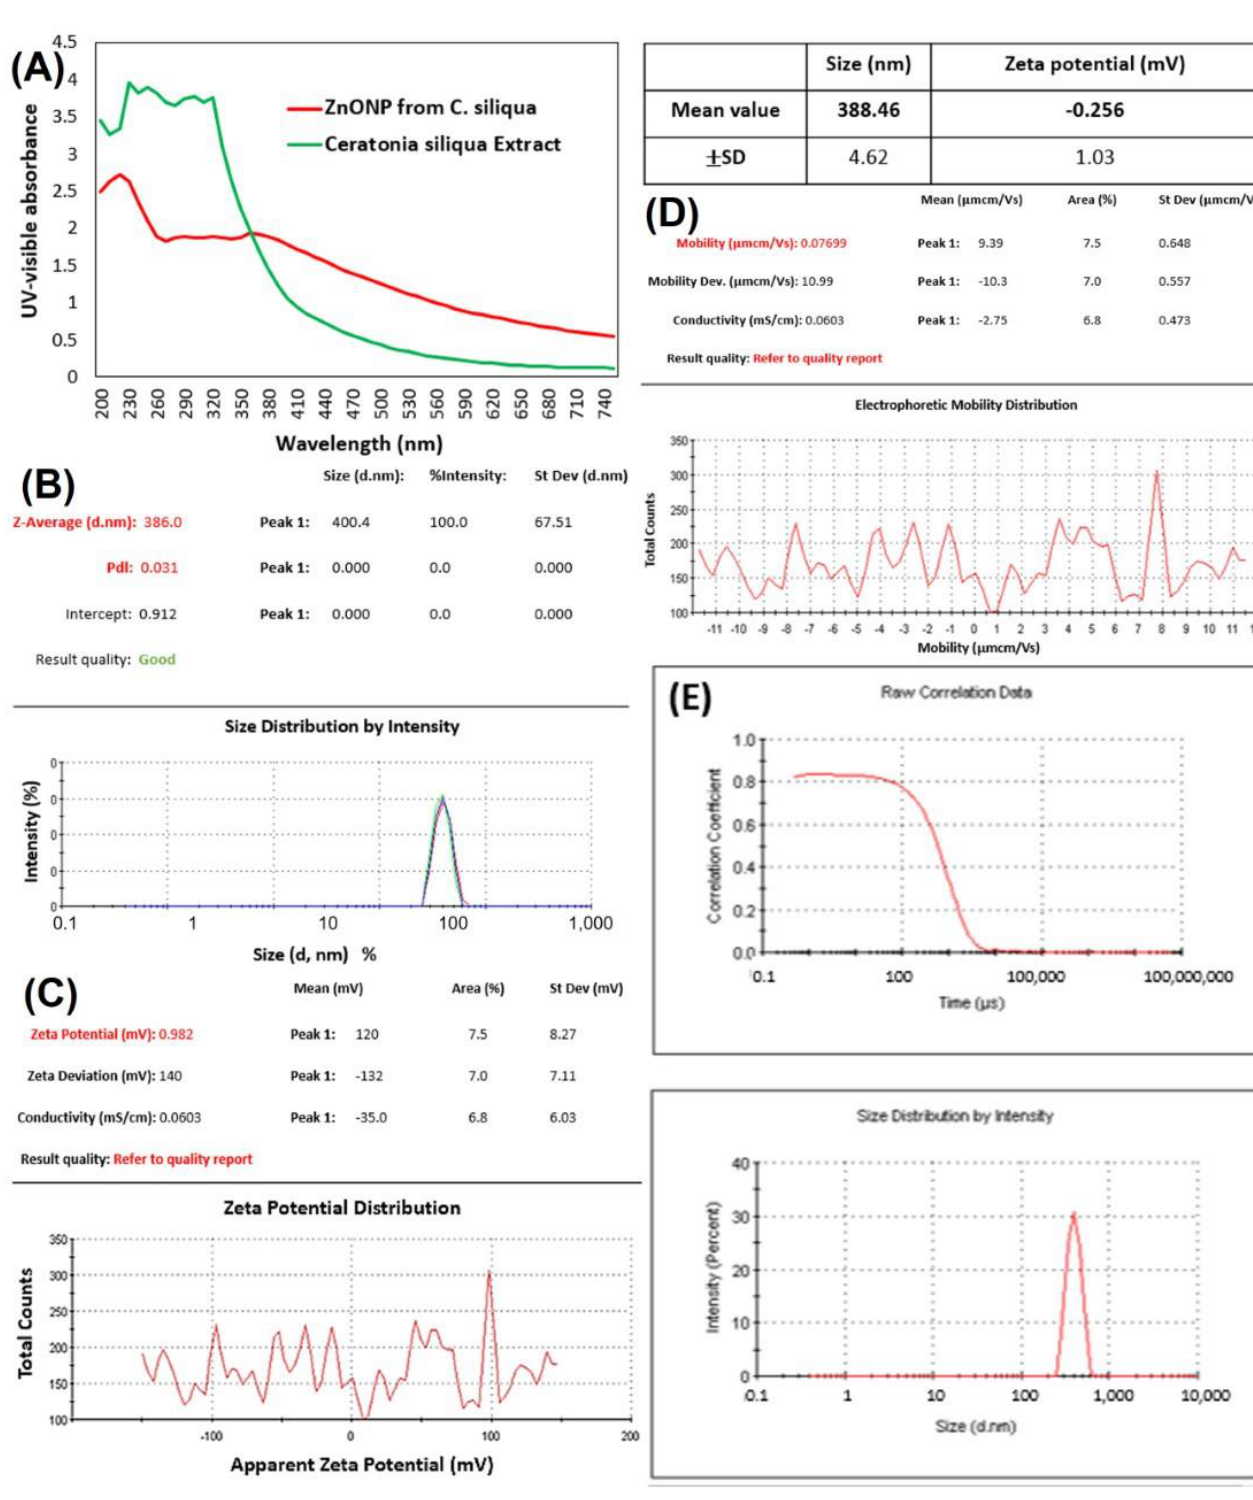
Figure 1. UV-vis absorption spectrum ( A ), size distribution ( B , E ), and zeta potential ( C , D ) of C. siliqua